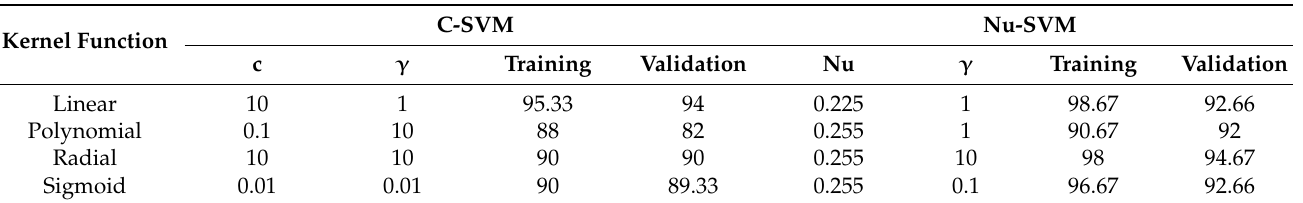
Table 4. Results and comparison of the Nu-SVM and C-SVM statistical models 1 subjected to kernel functions.